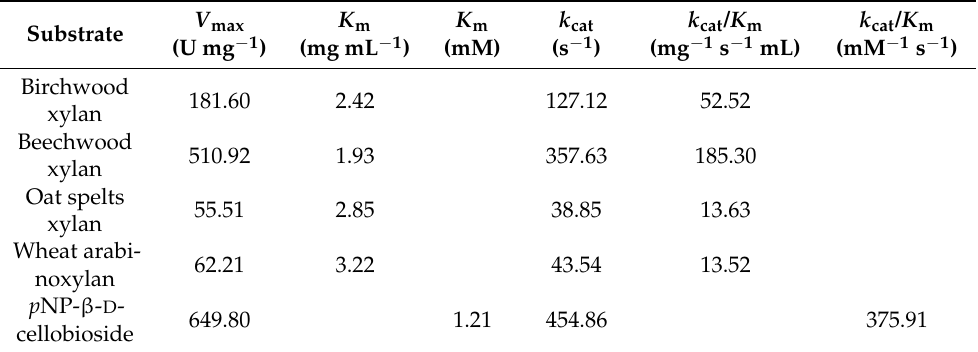
Table 3. Kinetic parameters of rXylR determined using different β -1,4- D -xylans and p NP- β